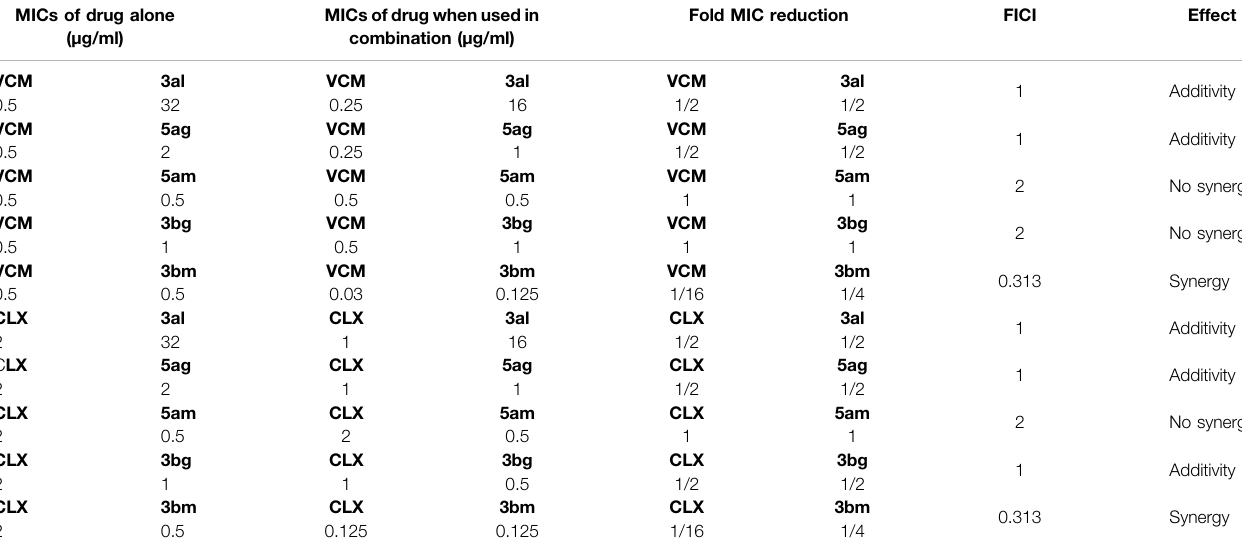
TABLE 5 | Synergistic studies of compounds 3al , 5ag , 5am , 3bg , and 3bm against clinical MRSA strains with vancomycin and cloxacillin, respectively. MICs of drug alone MICs ofdrugwhenusedin (µg/ml) combination